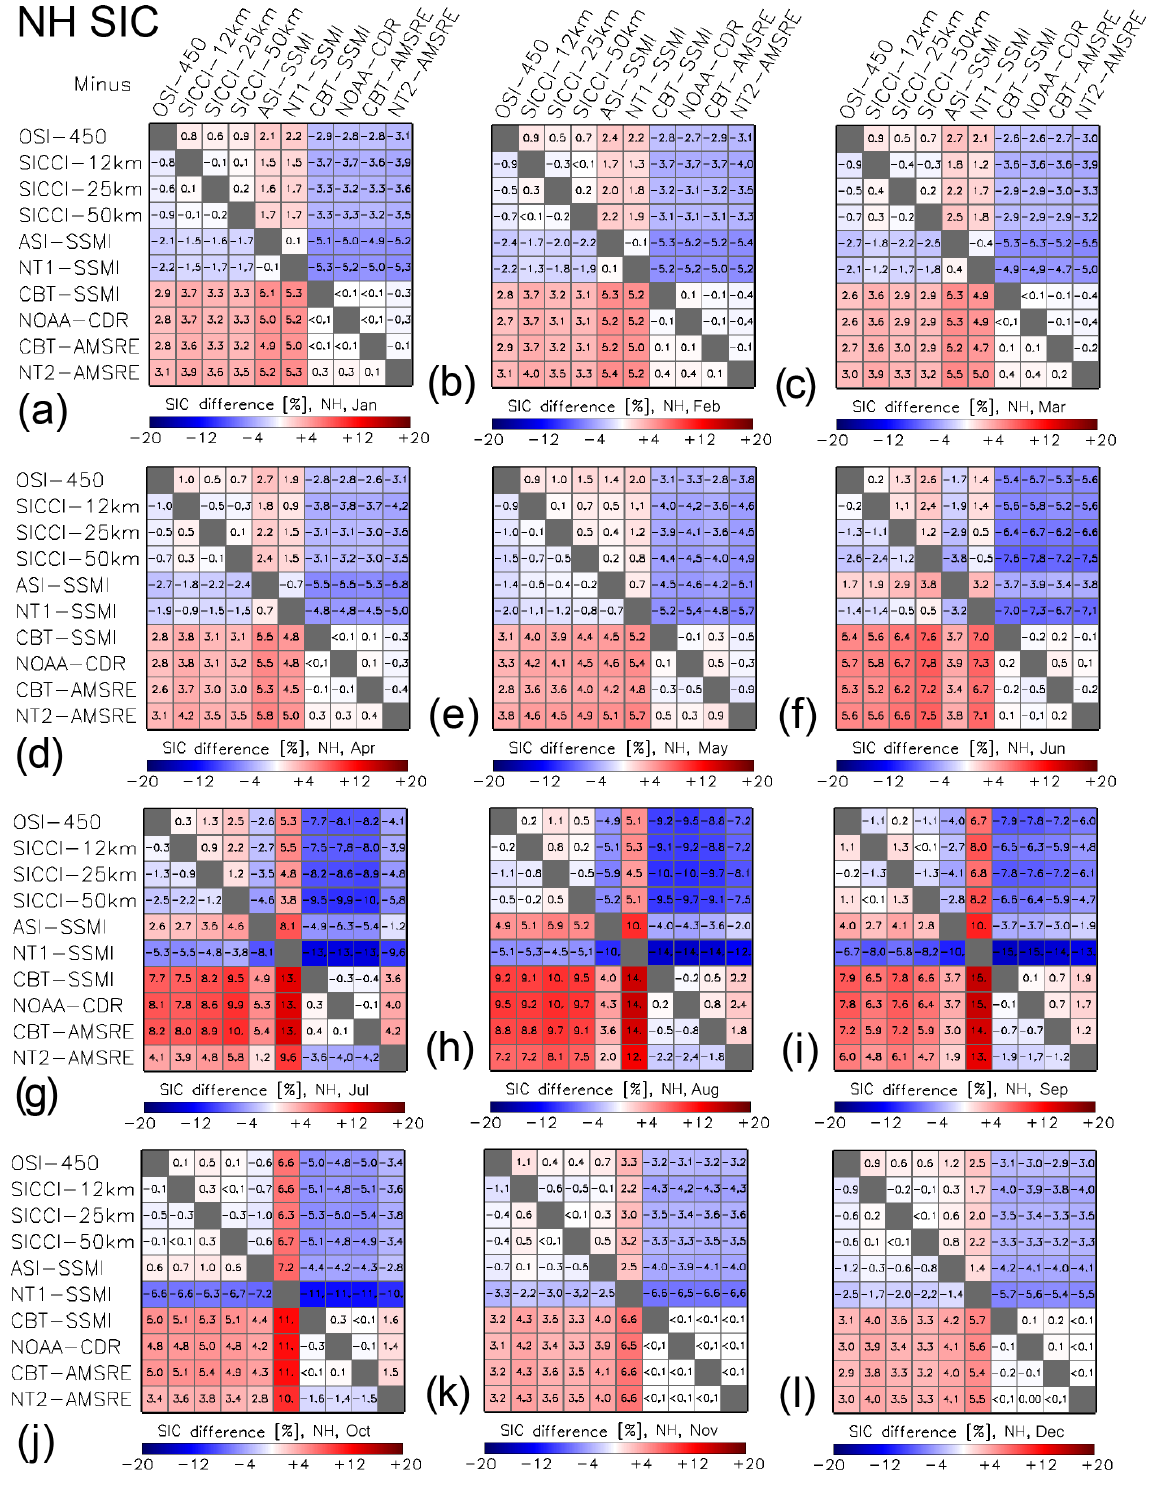
Figure G1. Differences between all 10 products of the average sea-ice concentration for the Arctic. The averages are computed from monthly mean values of the respective months of the AMSR-E period June 2002 to September 2011. All data are on the EASE-Grid 2.0 with 50km grid resolution. The land mask of the SICCI-50km product is applied to all